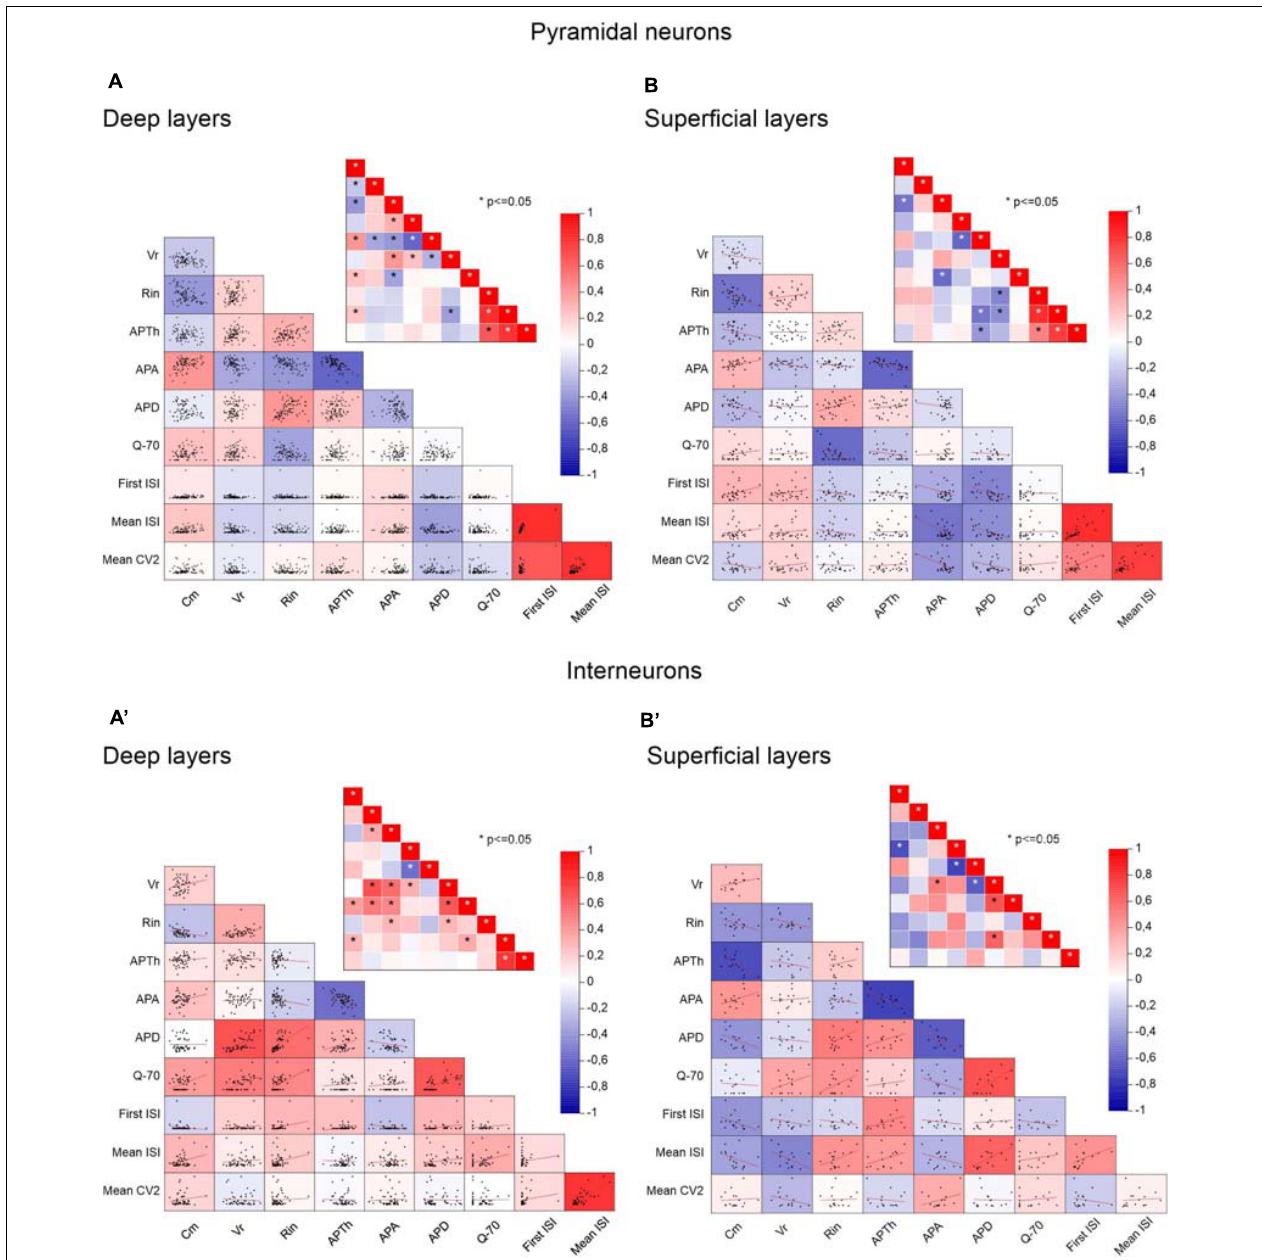
FIGURE 6 | Correlations between passive properties, firing properties, and resonance in the neurons of the different PRC layers. (A,B) Pairwise scatterplot matrices of C m (membrane capacitance), V r (membrane resting potential), R in (input resistance), AP Th (spike Threshold), AP A (spike Amplitude), AP D (spike Duration), Q - 70 , First ISI, Mean ISI, Mean CV2 of pyramidal neurons recorded from the deep (A) and the superficial (B) layers. These scatterplot matrices are overlaid on the corresponding color-coded correlation matrices and the insets in each panel represent the significance value associated with each scatterplot, computed as Pearson’s correlation coefficients. (A (cid:48) ,B (cid:48) ) Same as (A,B) for GABAergic interneurons. * p ≤